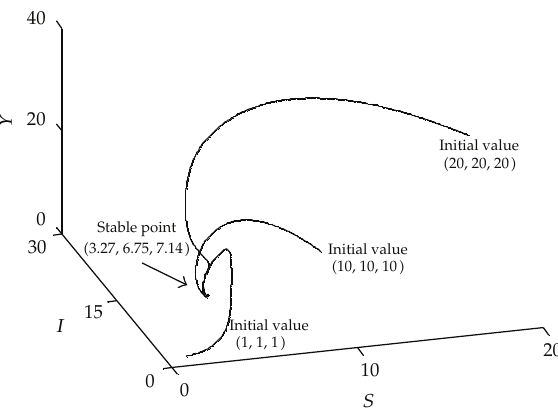
Figure 1: System (cid:5) 2.1 (cid:6) approaches globally asymptotically stable point under the parameters values (cid:5) 6.1 (cid:6) .